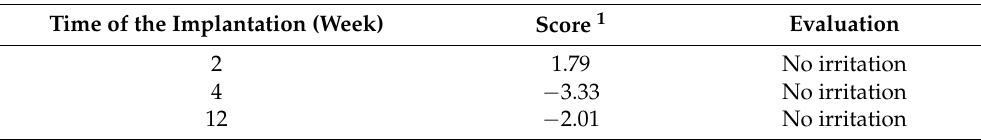
Table 8. Evaluation score used to estimate the general tissue response of the tested knitted implant (PACVD modified) that were implanted in the abdominal cavity (in sublay position). Time of the Implantation (Week) Score 1 Evaluation 2 1.79 No irritation 4 −3.33 No irritation 12 −2.01 (better biocompatibility). No